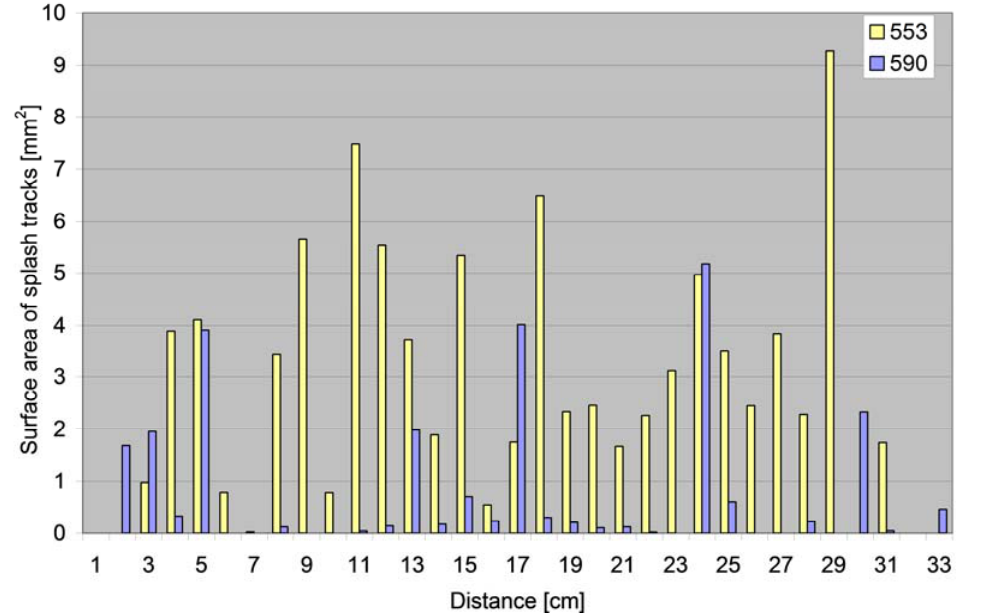
Figure 10. The surface areas of splash tracks recorded on the blotting paper in relation to distance (distances rounded to the nearest